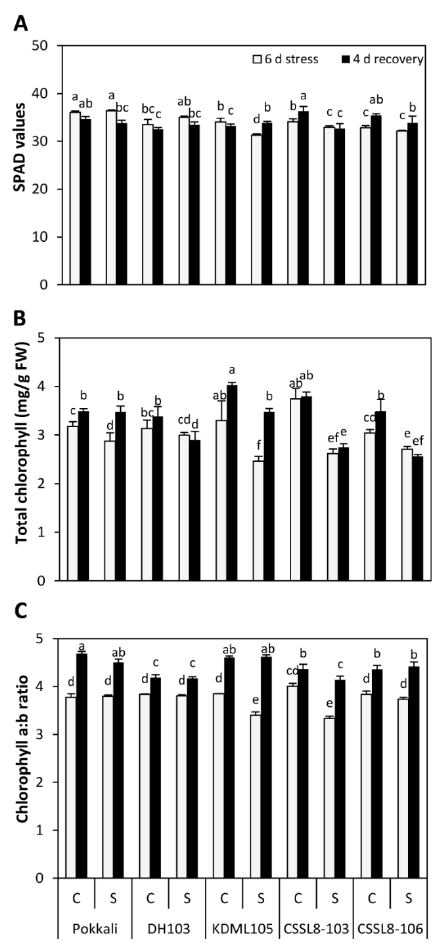
Figure 1. Photosynthetic pigments ( A ) SPAD values, ( B ) total chlorophyll content and chlorophyll a:b ratio ( C ) of rice plants under control and salt stress for 6 days (light gray bars) and after recovery for 4 days (black bars). C, control; S, salt stress. Pokkali, standard salt tolerant; DH103, drought tolerance quantitative trait loci (DT-QTL) donor; KDML105, recurrent parent; CSSL8-103 and CSSL8-106, improved lines. Values are means of four replications ± SE. Di ff erent letters indicate a significant di ff erence in the means of each group ( p ≤